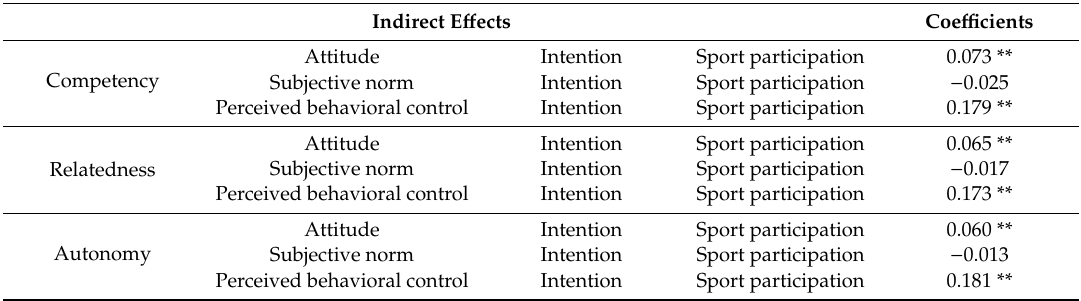
Table 2. The indirect e ff ects of self-determination theory constructs on sport participation. Indirect E ff ects Coe ffi